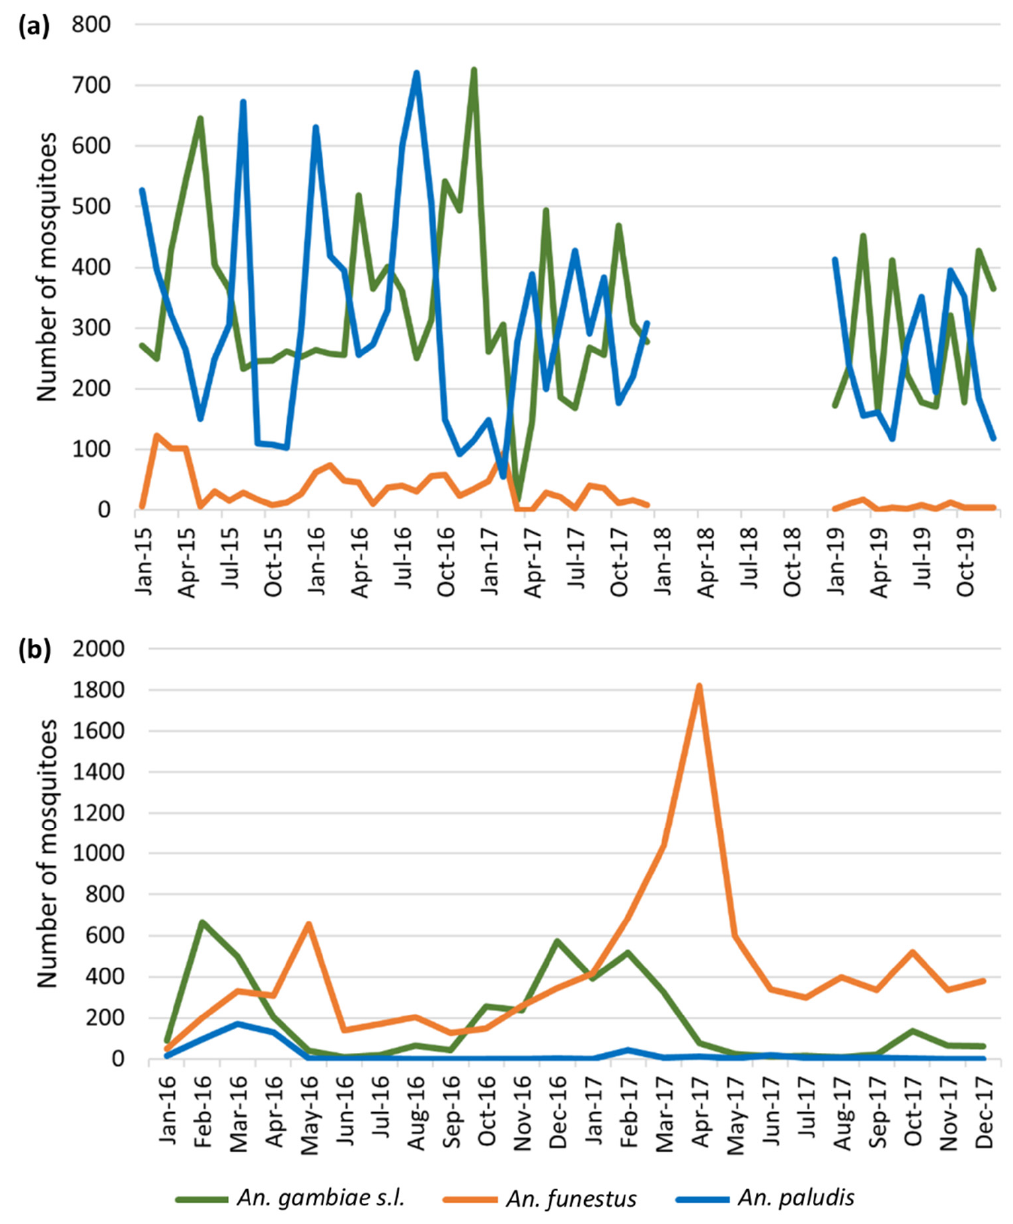
Figure 4. Monthly Anopheles collection data using human landing catches (HLC) from ( a ) Lodja in 2015–2017 and 2019 and ( b ) Kapolowe in 2016–2017. Monthly mosquito numbers are the sum of all mosquitoes collected at the eight HLC sampling locations in that given month.